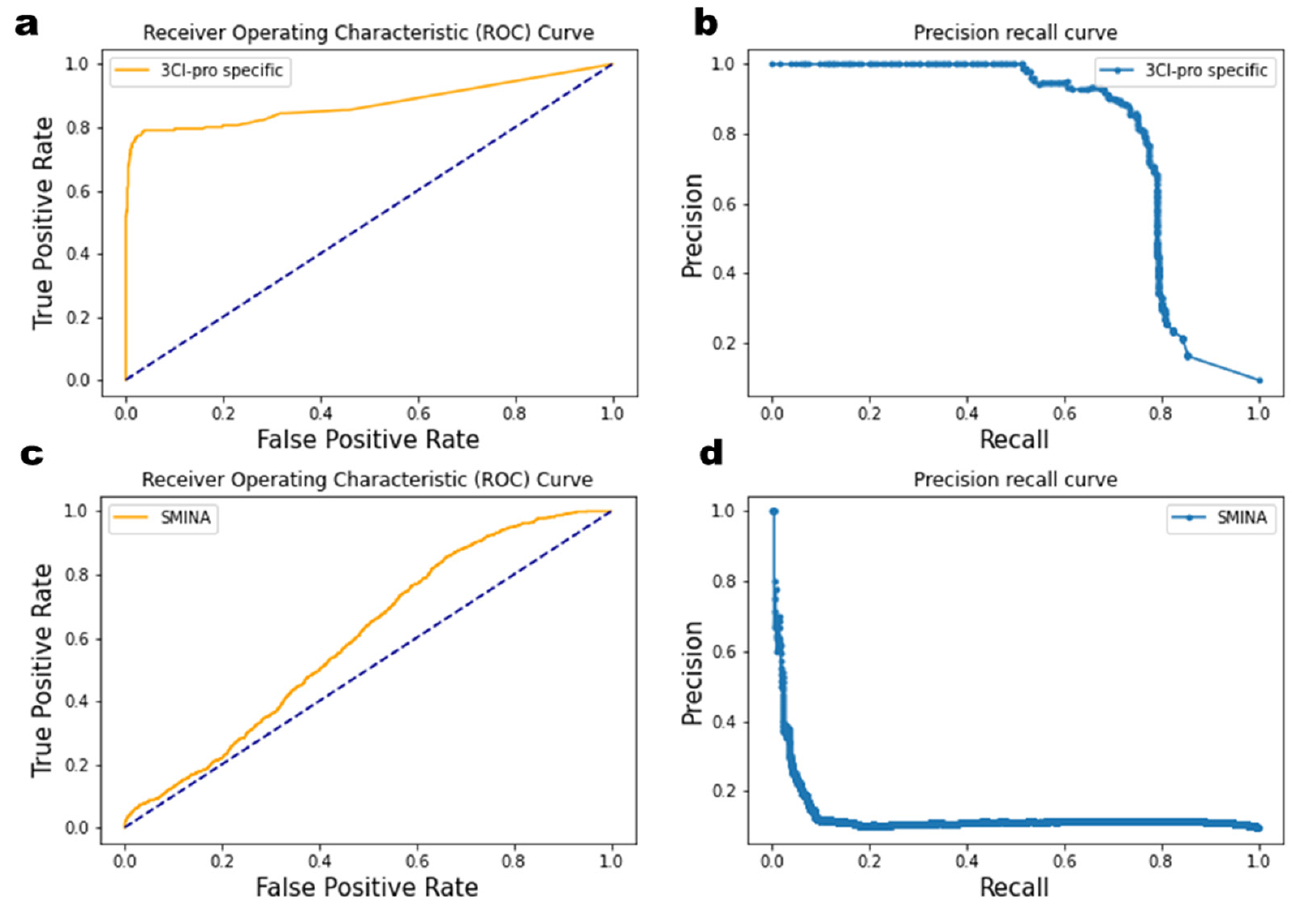
Figure 5. Target specific scoring function performance: ( a , c ) ROC curve, and ( b , d ) precision-recall curve.